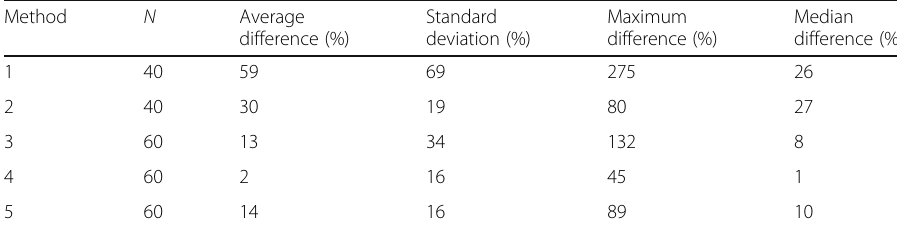
Table 1 Difference values (as a percentage) between various methods with sub-complete data when compared to the full data set analysis (gold standard method); method 1: t 1/2 average applied to 4 h data; method 2: t 1/2 average applied to 24 h data; method 3: t 1/2 patient from cycle 1 applied to 4 h data on subsequent cycles; method 4: t 1/2 patient from cycle 1 applied to 24 h data on subsequent cycles; method 5: cycle 1 %IA at 120 h applied to subsequent cycles with